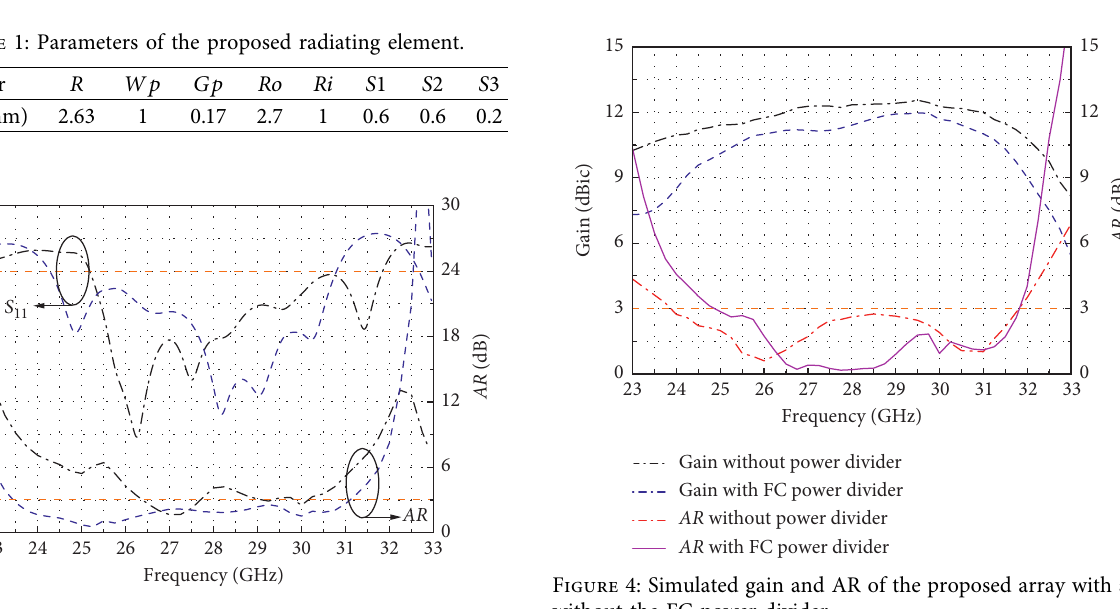
and AR with De . 11